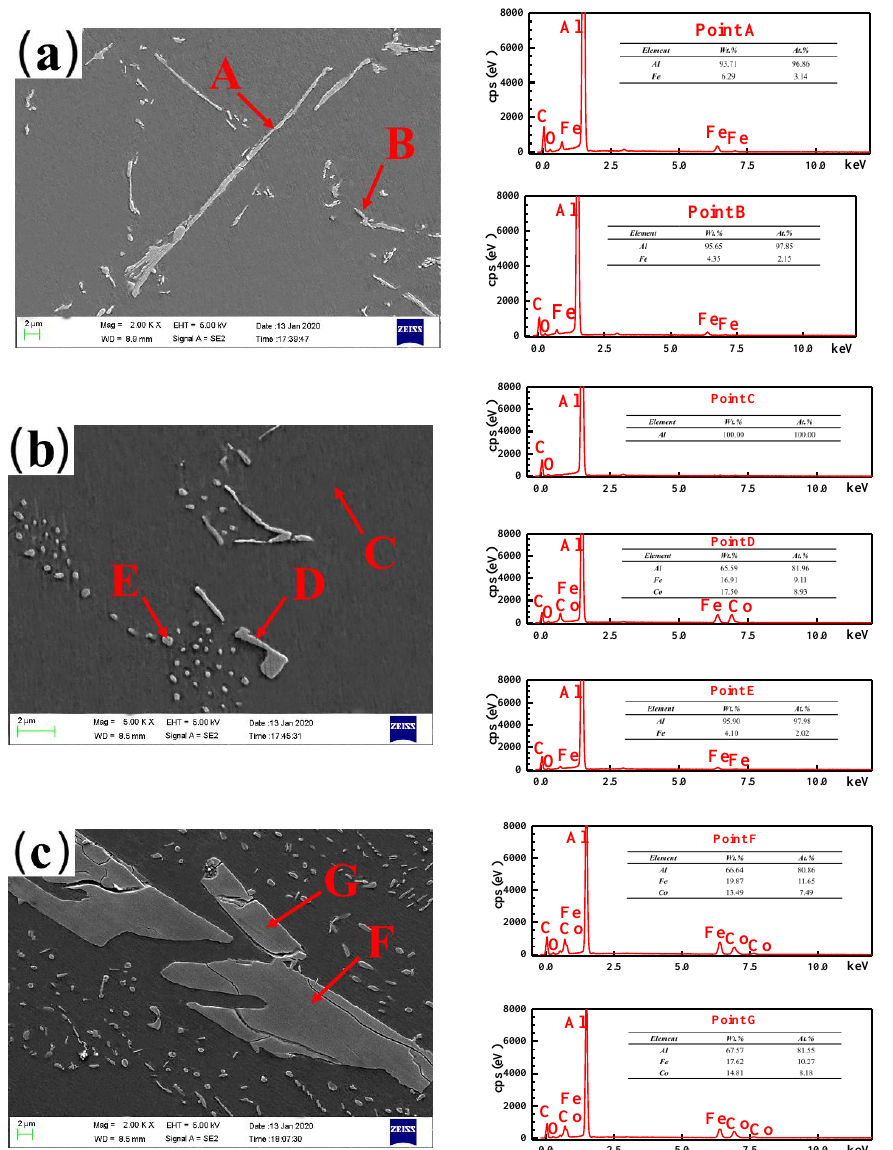
Figure 4. SEM-SEimagesofas-cast( a )Al–2Fe,( b )Al–2Fe-0.3Co, ( c )Al-2Fe-0.8Coalloys, andcorresponding Figure 4. SEM-SE images of as-cast ( a ) Al–2Fe, ( b ) Al–2Fe-0.3Co, ( c ) Al-2Fe-0.8Co alloys, and EDS corresponding EDS results.